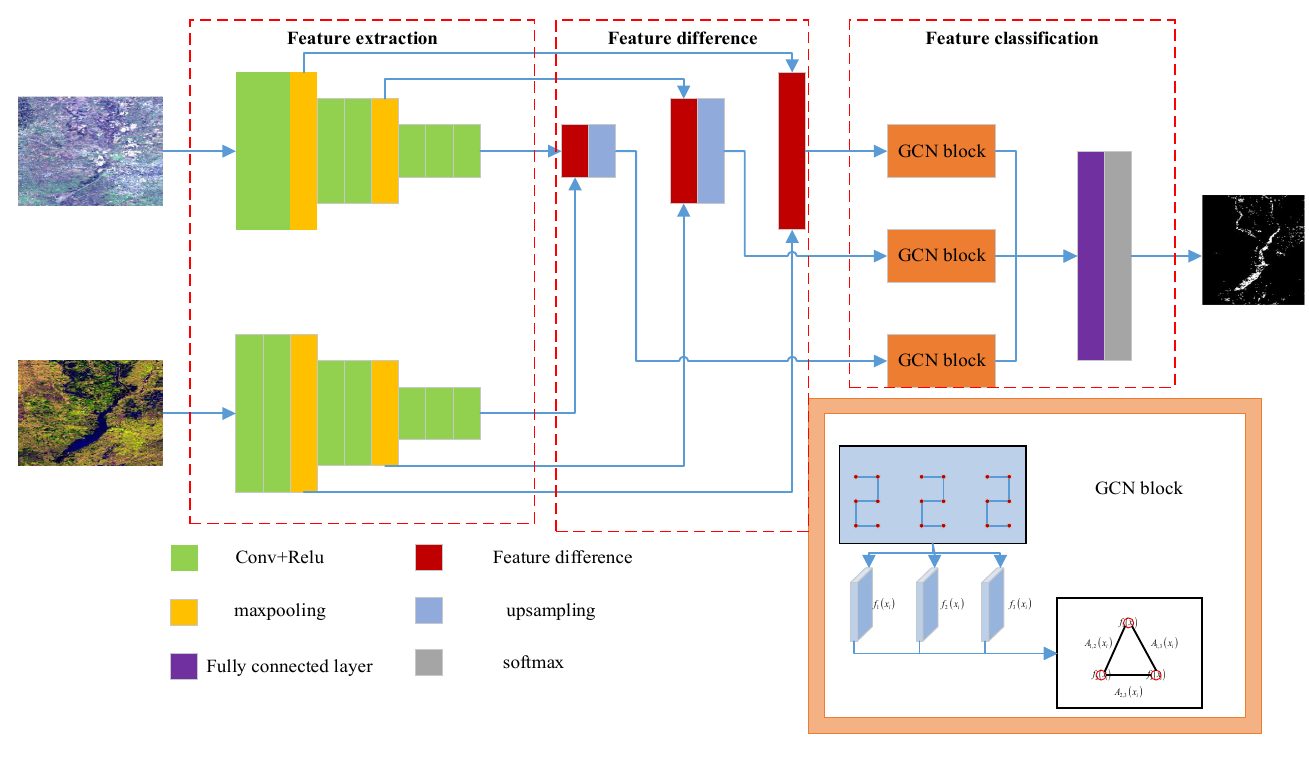
Figure 1. The principle of our proposed method. Table 1. Detailed structure of our network.